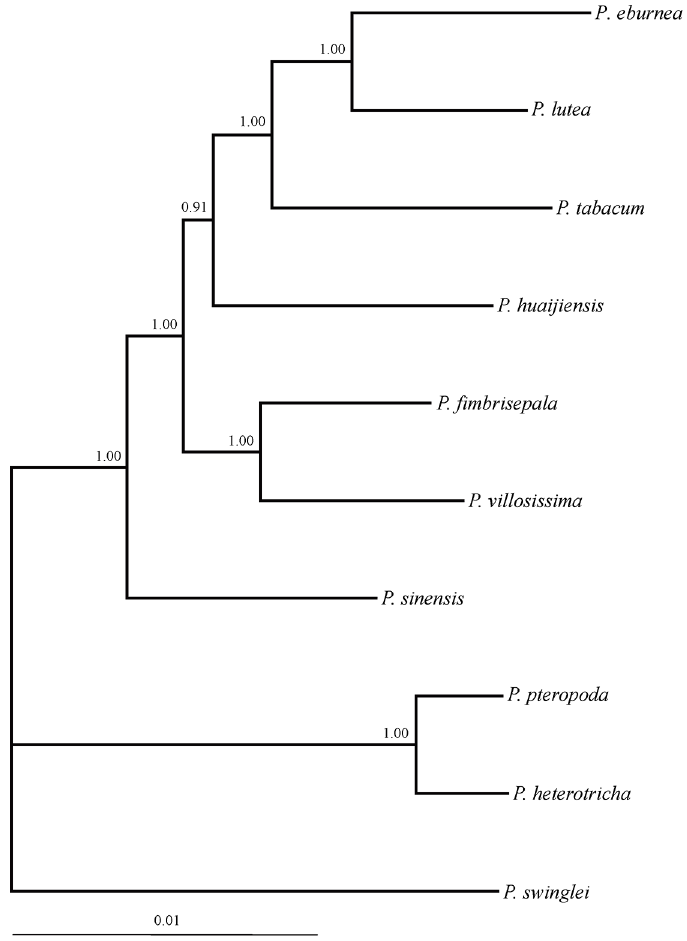
Fig 2. Bayesian phylogenetic tree of full-length PHYE sequences for 10 Primulina species. The tree was rooted at P . swinglei . Posterior probabilities were labeled at the nodes.